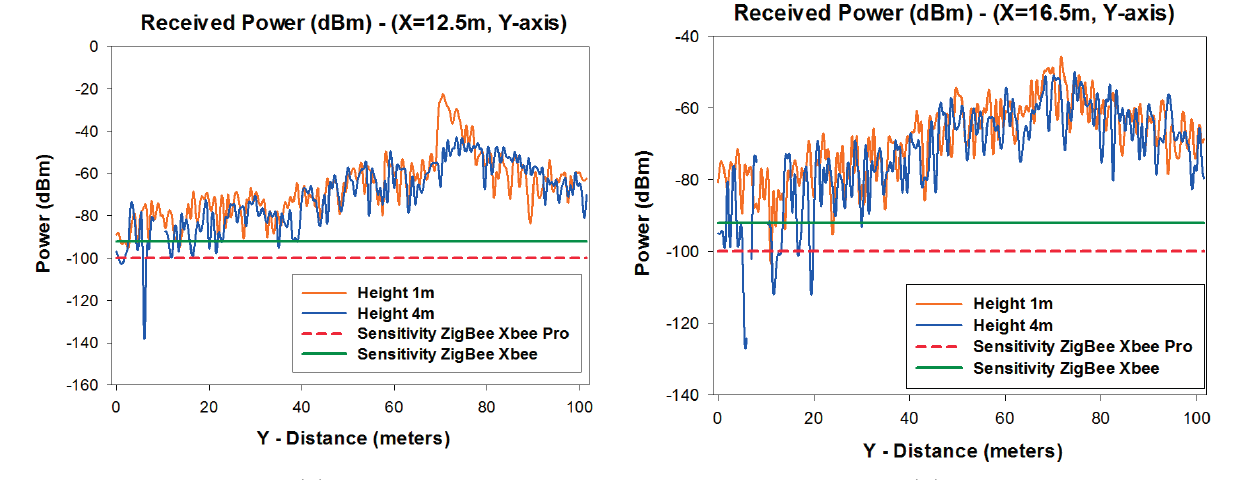
Figure 12. Comparison of radial of received power (dBm) along the Y-axis with the receiver sensitivity ( a ) ZigBee Xbee Pro and ZigBee Xbee for X = 12.5 m ( b ) ZigBee Xbee Pro and ZigBee Xbee for X = 16.5 m ( c ) BLE system ( d ) Classic